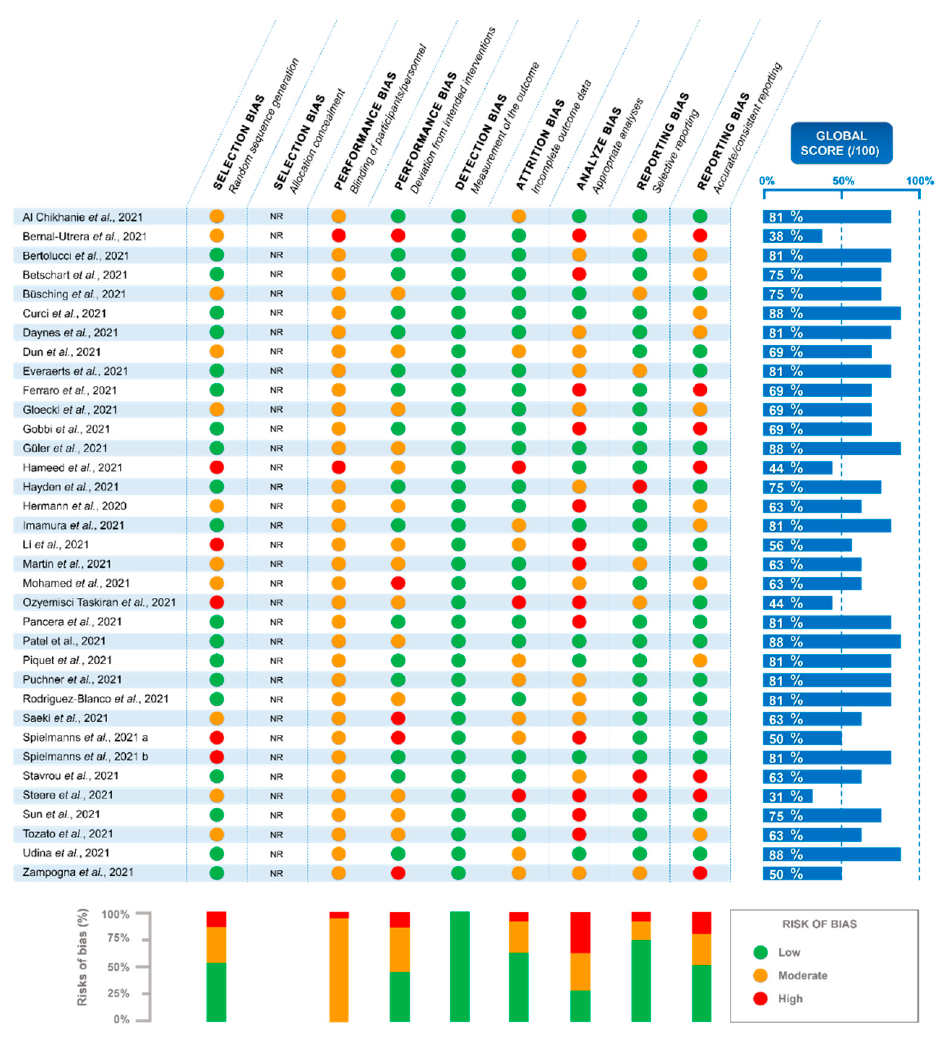
Figure 2. Analysis of the risks of bias in the studies included in the systematic review [35–69].